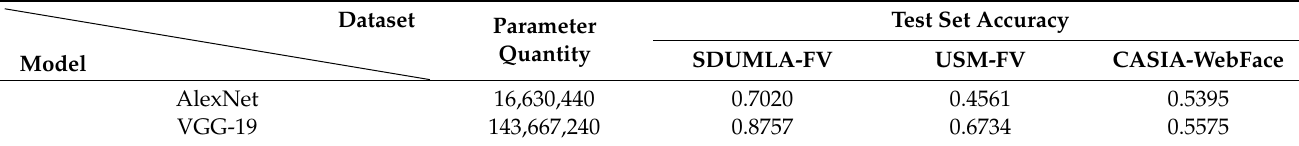
Table 4. Results of a single-mode experiment.